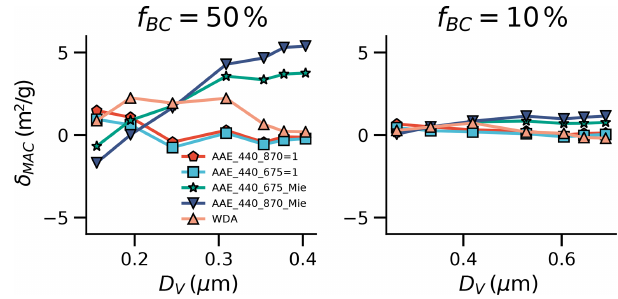
Figure 9. Similar to Fig. 5 but for internally mixed particles ( D f = 1 . 8; λ =